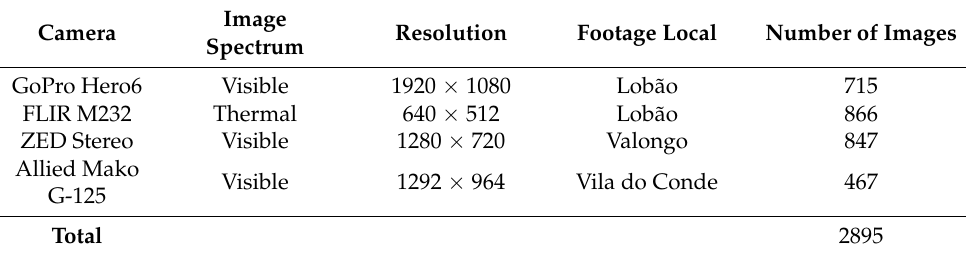
Figure 1. Robotic platforms used to acquire the forest images: on the left side is shown AgRobV16 and on the right side is shown AgRobV18. Table 1. Original dataset